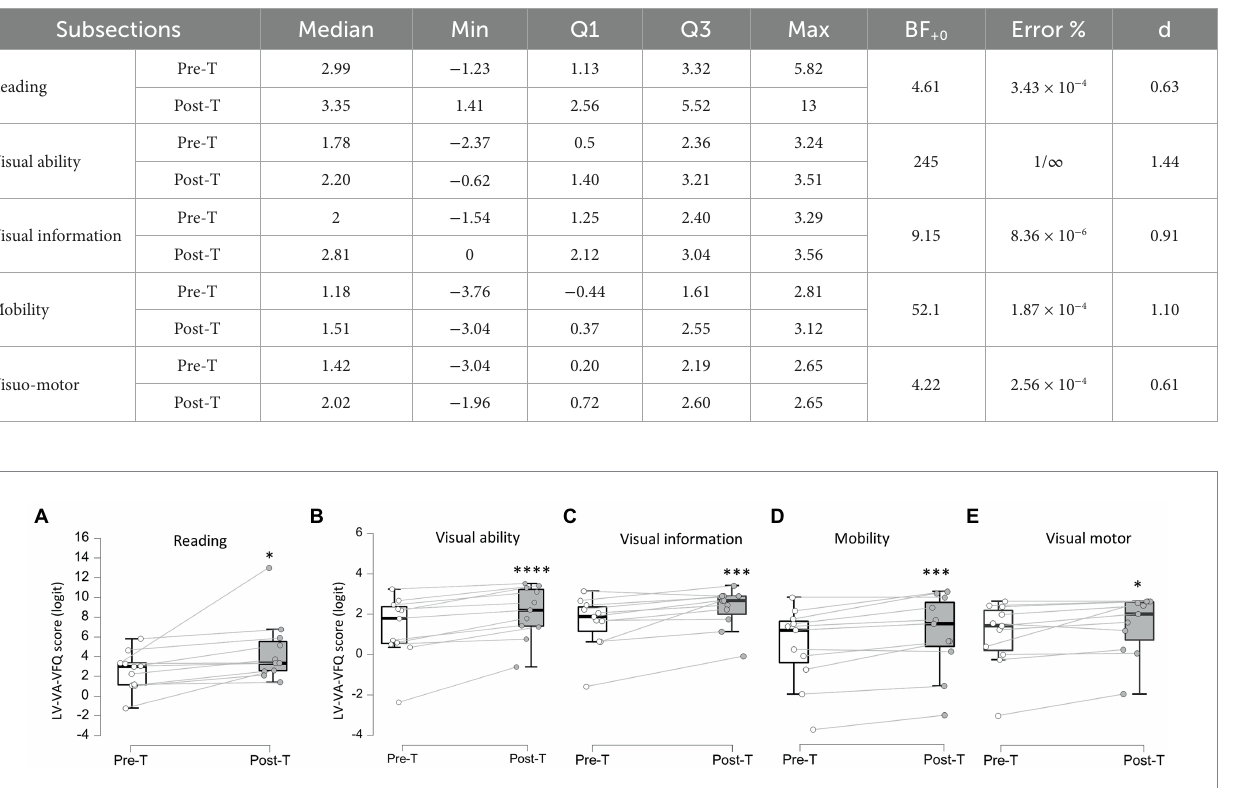
TABLE 2 LV-VA-VFQ-48 sub-group scores.